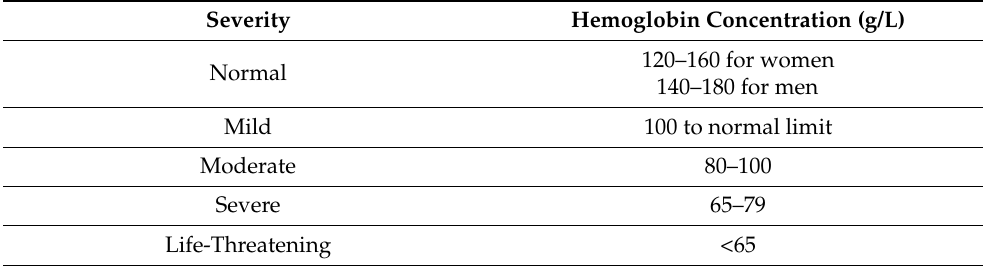
Table 6. The anemia diagnosis status